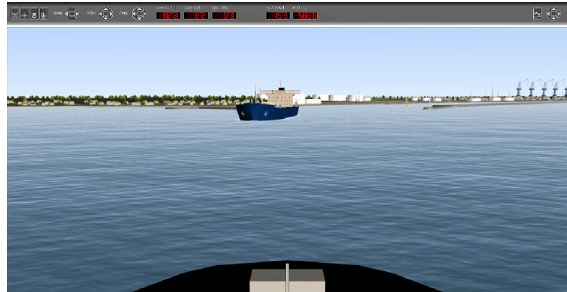
Fig. 8. PANAMAX tanker and a ferry sailing in opposite directions in the port entrance channel